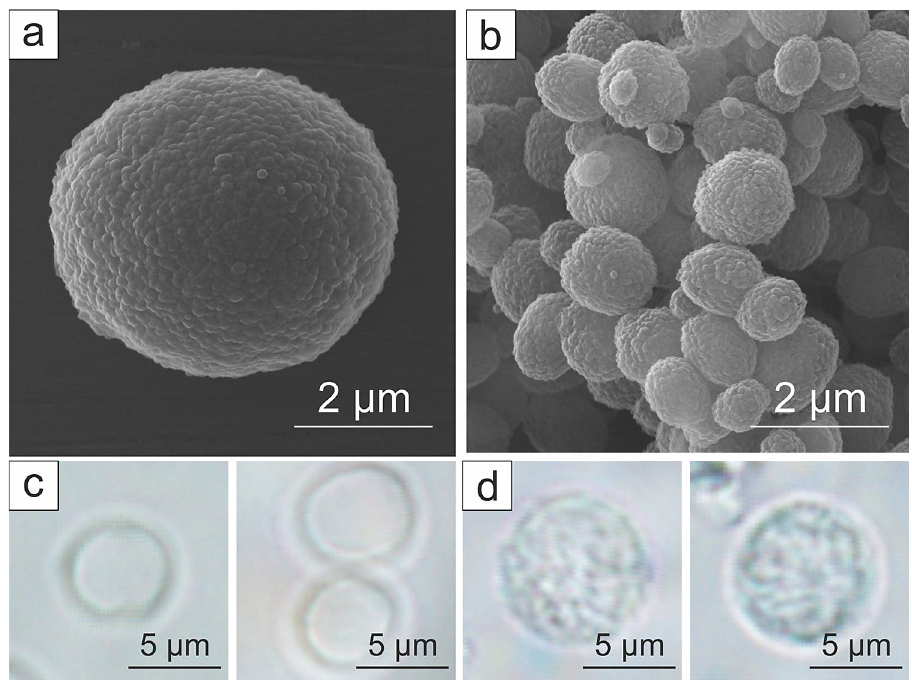
Figure 4. WBCs and platelets phantoms. ( a , b ) SEM images of ( a ) WBC phantoms and ( b ) platelets phantoms, ( c ) optical microscopy images of WBC phantoms, ( d ) optical microscopy images of human